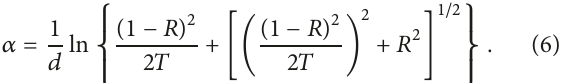
Figure 4: Transmittance ( T ) and reflectance ( R ) spectra for the PbS thin films at different